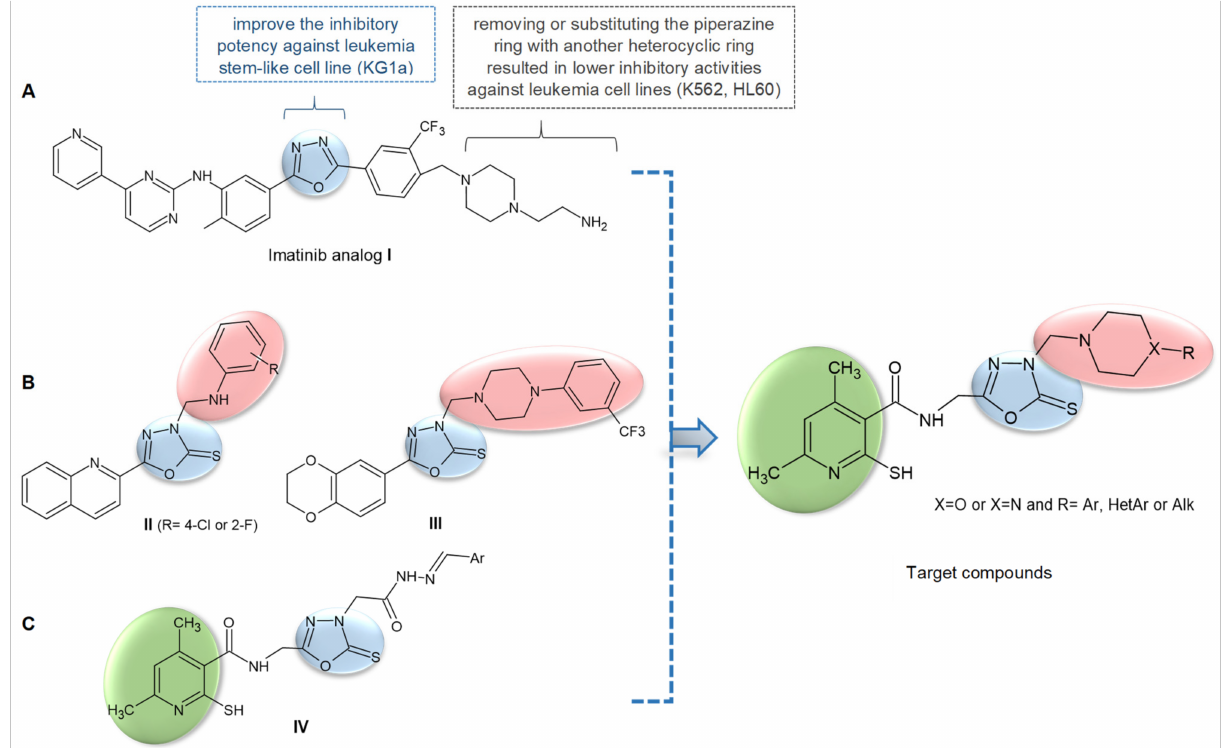
Figure 1. ( A ) The 1,3,4-oxadiazole analog of imatinib with structure–activity relationships; ( B ) 1,3,4-Oxadiazole-derived N -Mannich bases with anticancer activity; ( C ) Our previously reported anticancer 1,3,4-oxazdiazole derivatives, and general structure of the target